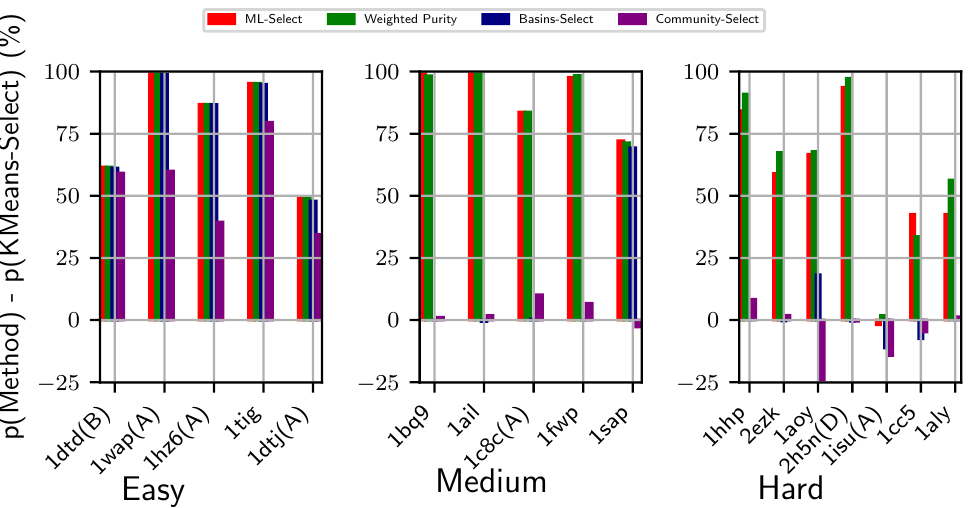
Figure 2. Visualization of two supervised and two unsupervised decoy selection strategies. The y -axis tracks the difference in purity of the top basin predicted by each method with the purity of the top (largest) cluster obtained by KMeans-Select . The x -axis tracks the PDB entry id of each target protein. Color-coding is used to distinguish the different methods under comparison. The left, middle, and right panels show results for the easy, medium, and hard datasets,